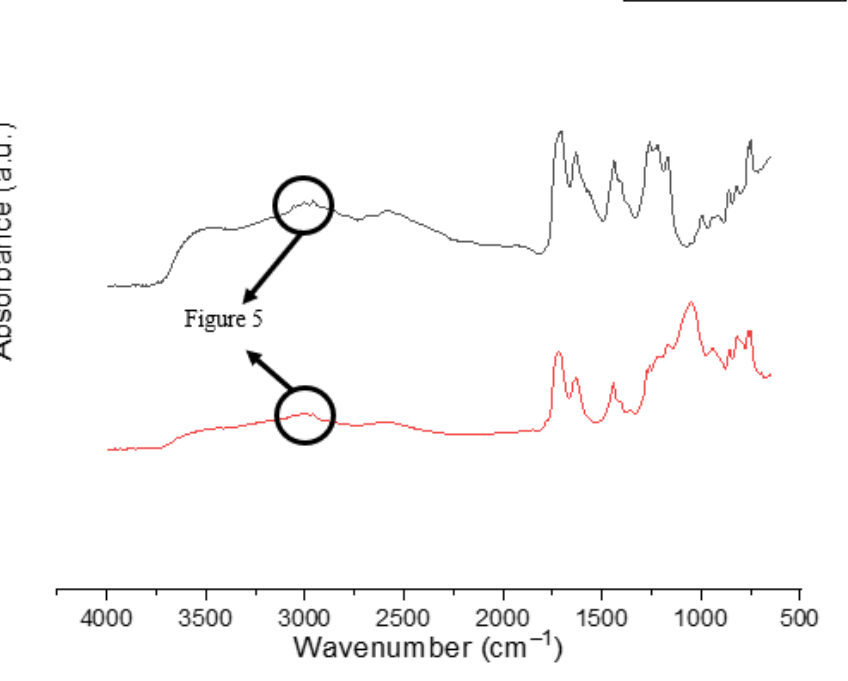
Figure 4. FT-IR comparison of Ti-MAH and Ti-MAH-Si.